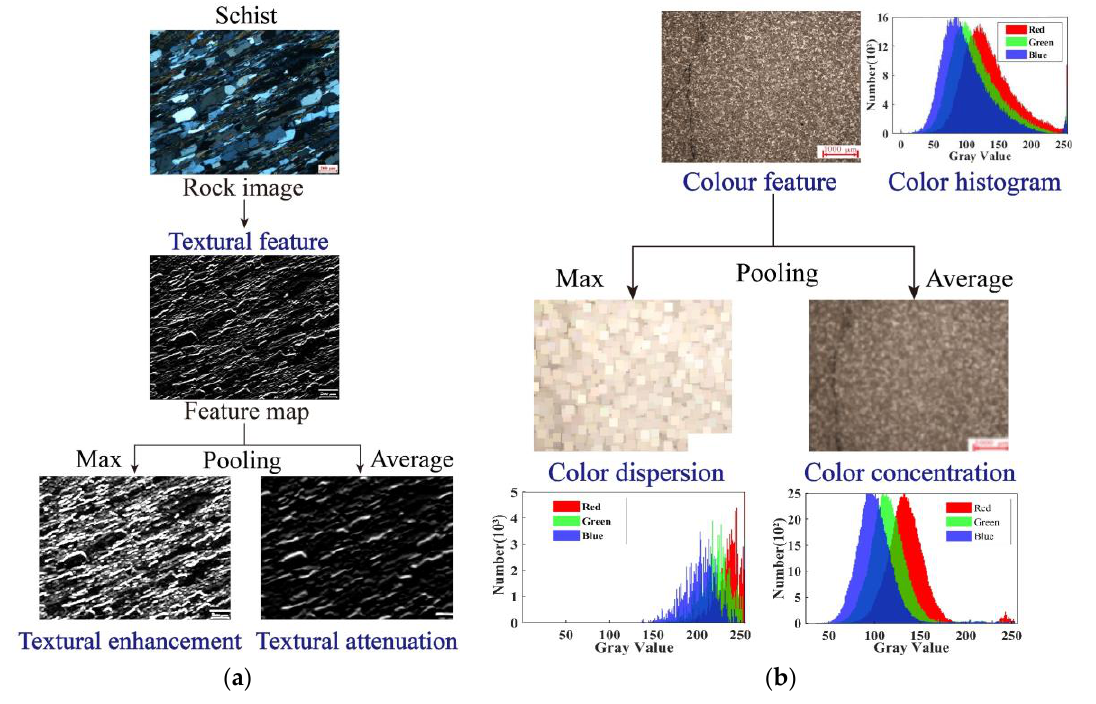
Figure 5. Process of traditional pooling methods, including max pooling, average pooling and sto- chastic pooling.